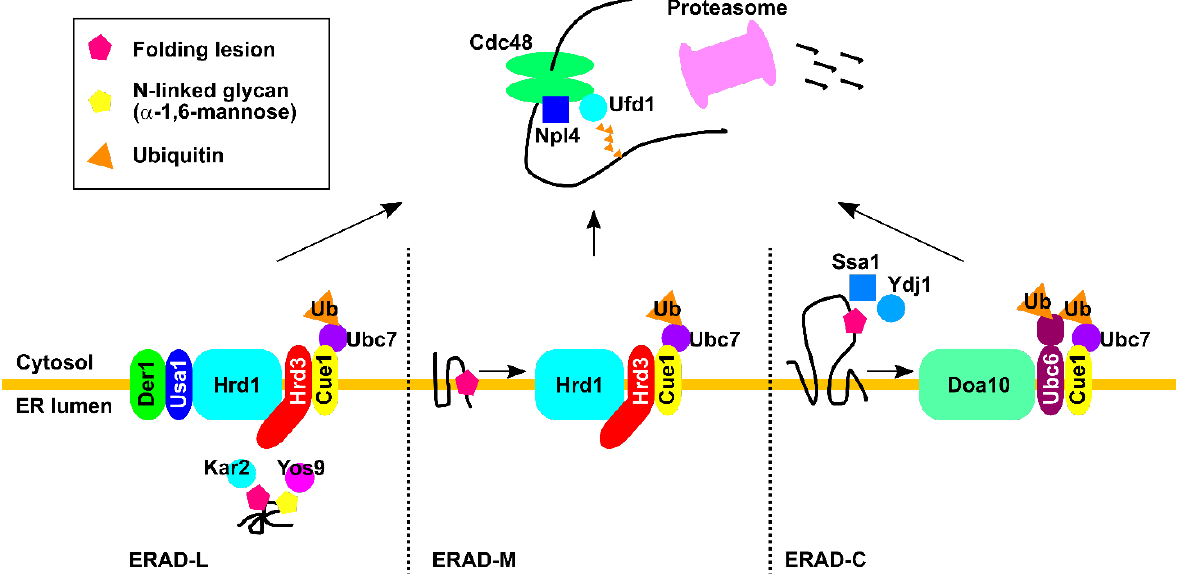
Figure 1. The ERAD (ER-associated degradation) pathway in Saccharomyces cerevisiae (see text for detail).